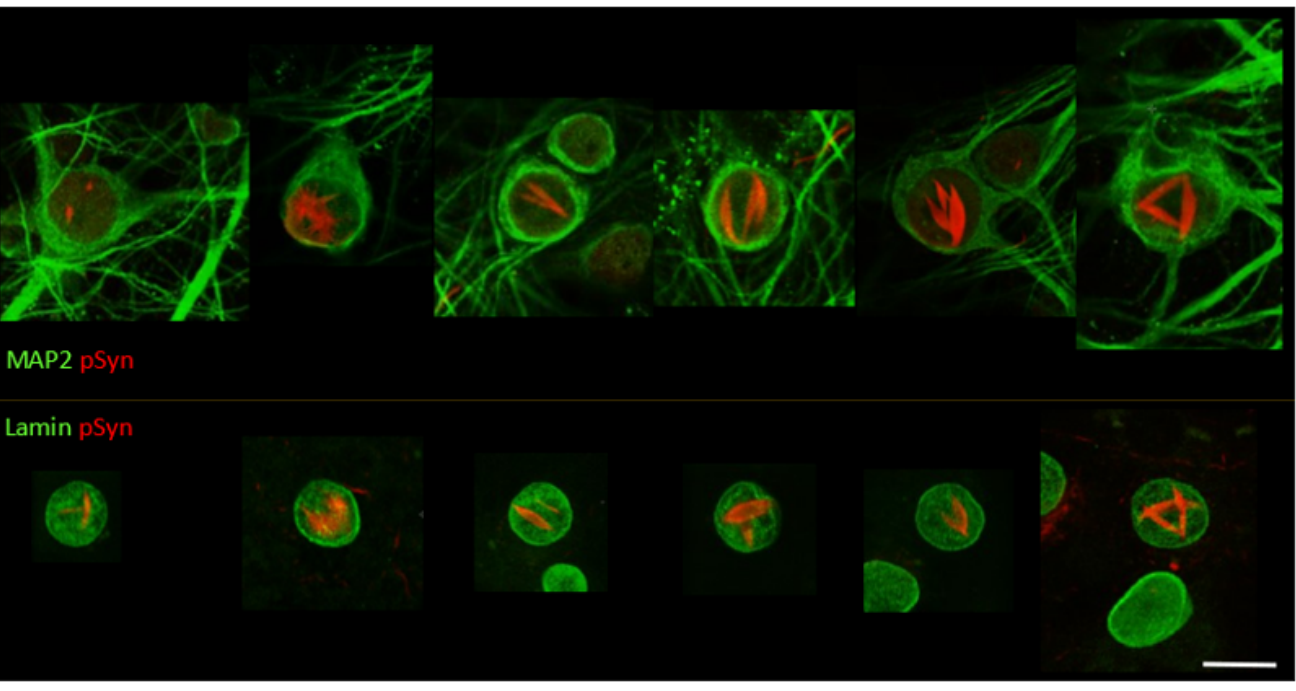
Figure 4. LSCM optical sections of 30 DIV mouse primary cortical neurons treated at DIV7 with 1B fibrils. Phospho-S129 α -Syn-positive inclusions (NIIs) are coded in red; upper row: MAP2 is in green; lower row: Lamin is in green. Scale bar: 10 μ m.